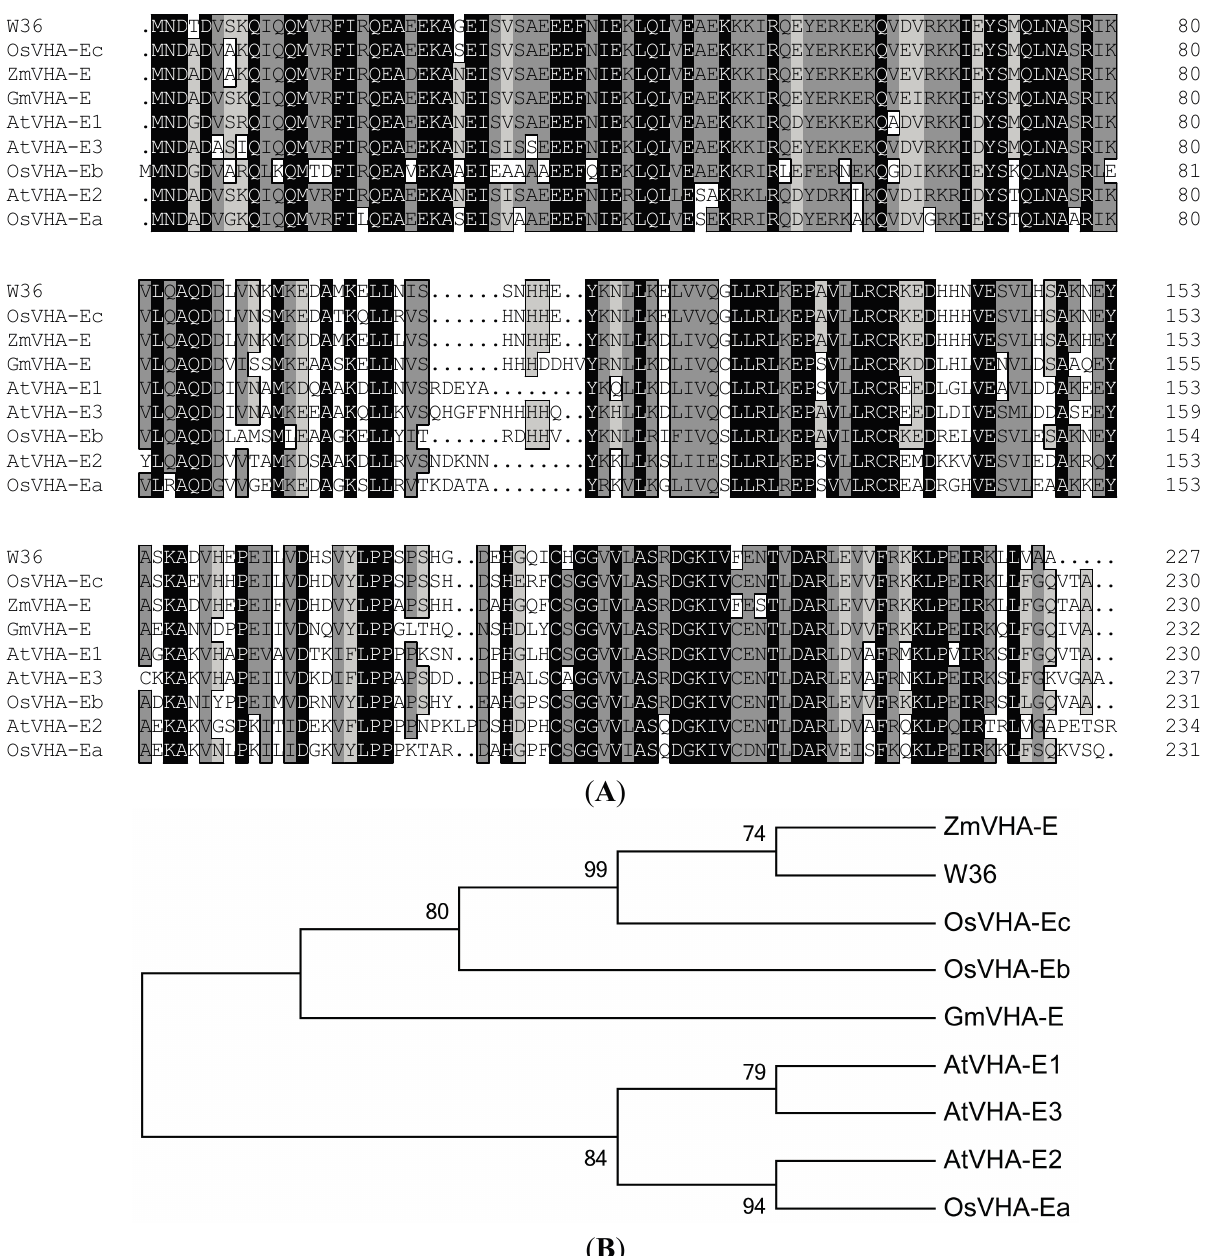
Figure 1. Sequence alignment and phylogenetic analysis of W36 with other related proteins. ( A ) Sequence alignment of W36 with other related proteins. Alignment of V-type H + -ATPase E subuint proteins with products of homologous genes from other plants: AtVHA-E1 (Acc. NP_192853.1), AtVHA-E2 (Acc. NP_187468.1), AtVHA-E3 (Acc. NP_176602.1), OsVHA-Ea (Acc. NP_001055857.1), OsVHA-Eb (Acc. NP_001042437.1), OsVHA-Ec (Acc. NP_001043767.1), ZmVHA-E (Acc. ACG31413.1), GmVHA-E (Acc. XP_003533059.1). Identical amino acids are in black boxes, similar amino acids are in grey boxes; ( B ) phylogenetic analysis of W36 with other related proteins. Phylogenetic